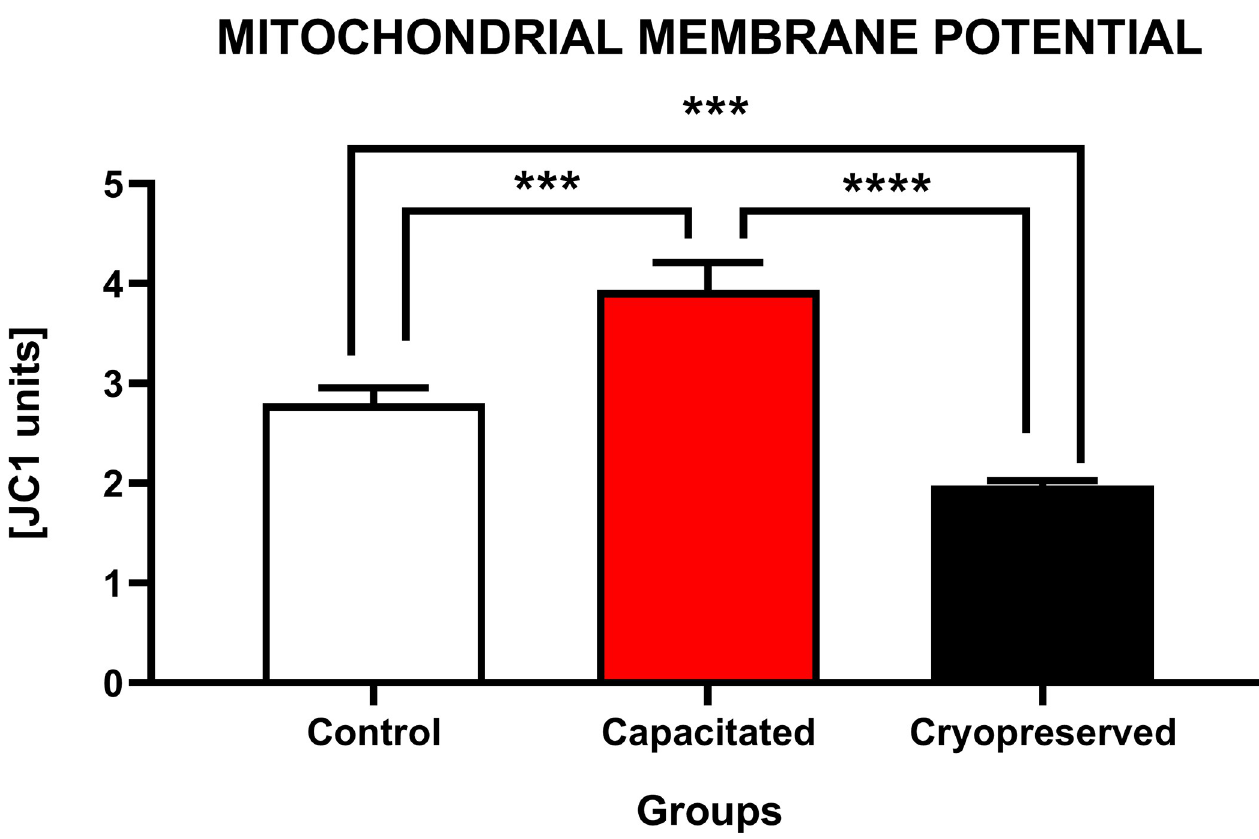
Fig 3. Mitochondrial membrane potential of of non-capacitated, in vitro capacitated and cryopreserved bovine spermatozoa. Each bar represents the values of mitochondrial activity (JC1 units) between experimental groups ( ± SD). The level of significance was set at � P < 0.05; �� P < 0.01; ��� P < 0.001; ���� P <